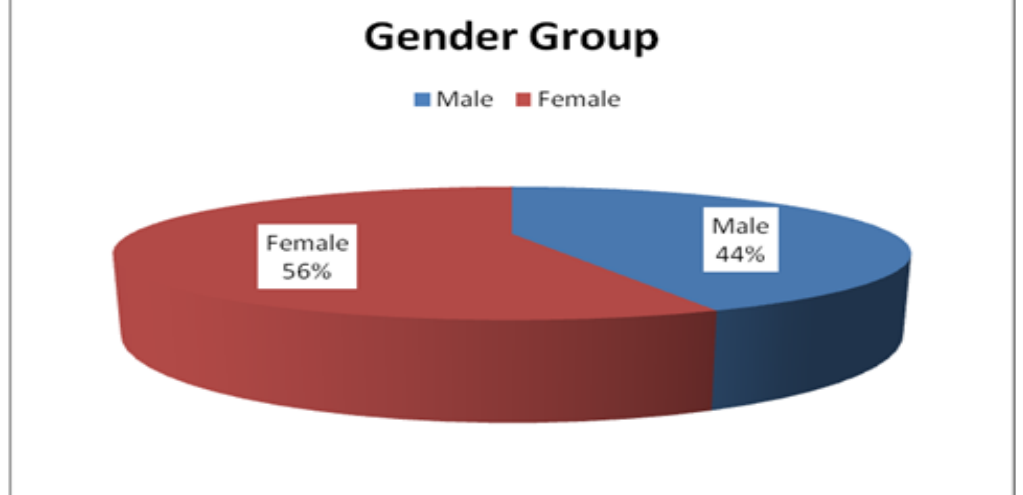
Figure 2. Distribution of study population according to gender.